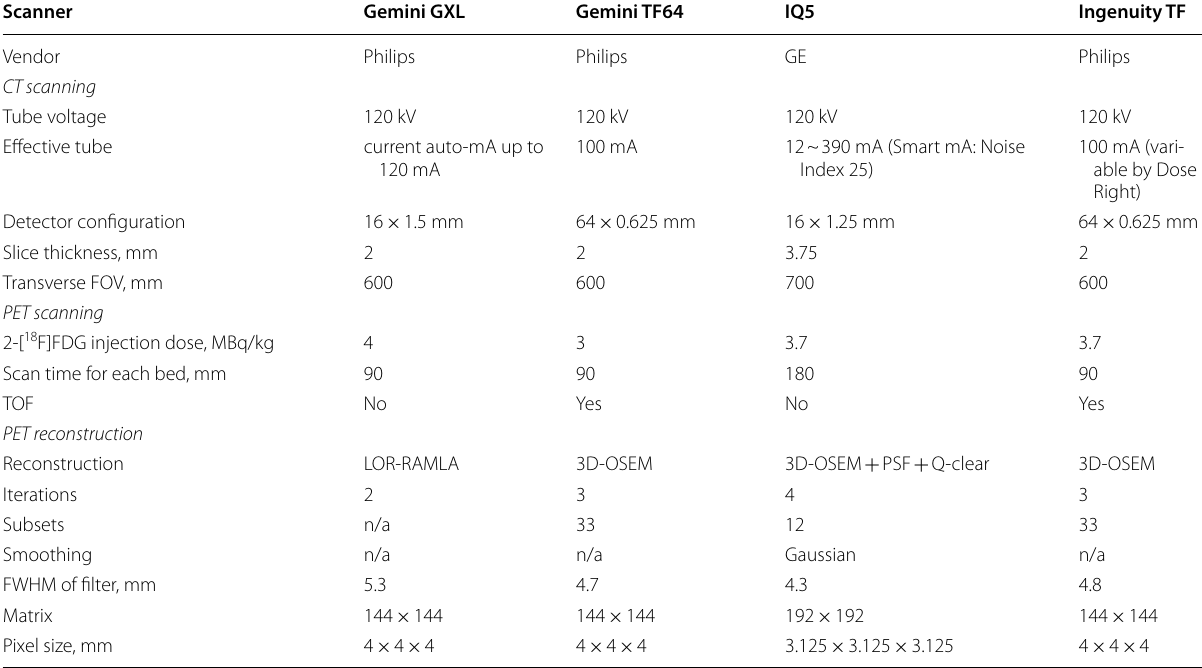
Table 2 Clinical parameters of PET/CT